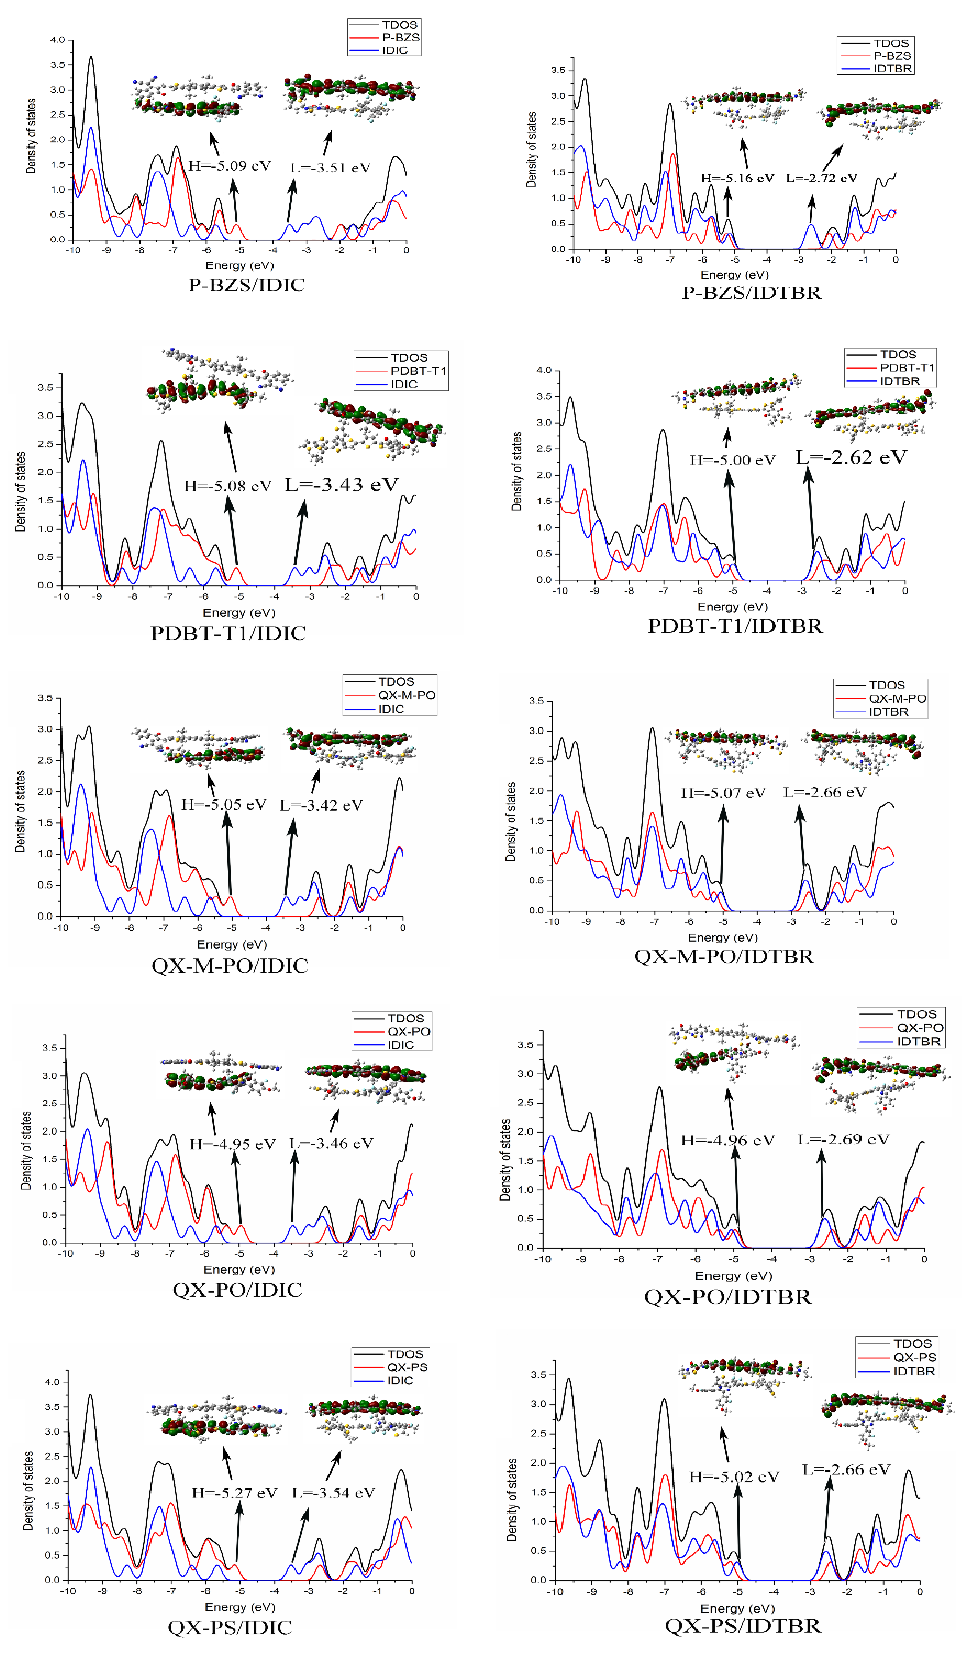
Figure 9. The partial density of states (PDOS) plots and frontier molecular orbital plots of ten D/A interfaces (For all D/A interfaces, the NFAs are on the top, and the polymers are underneath).